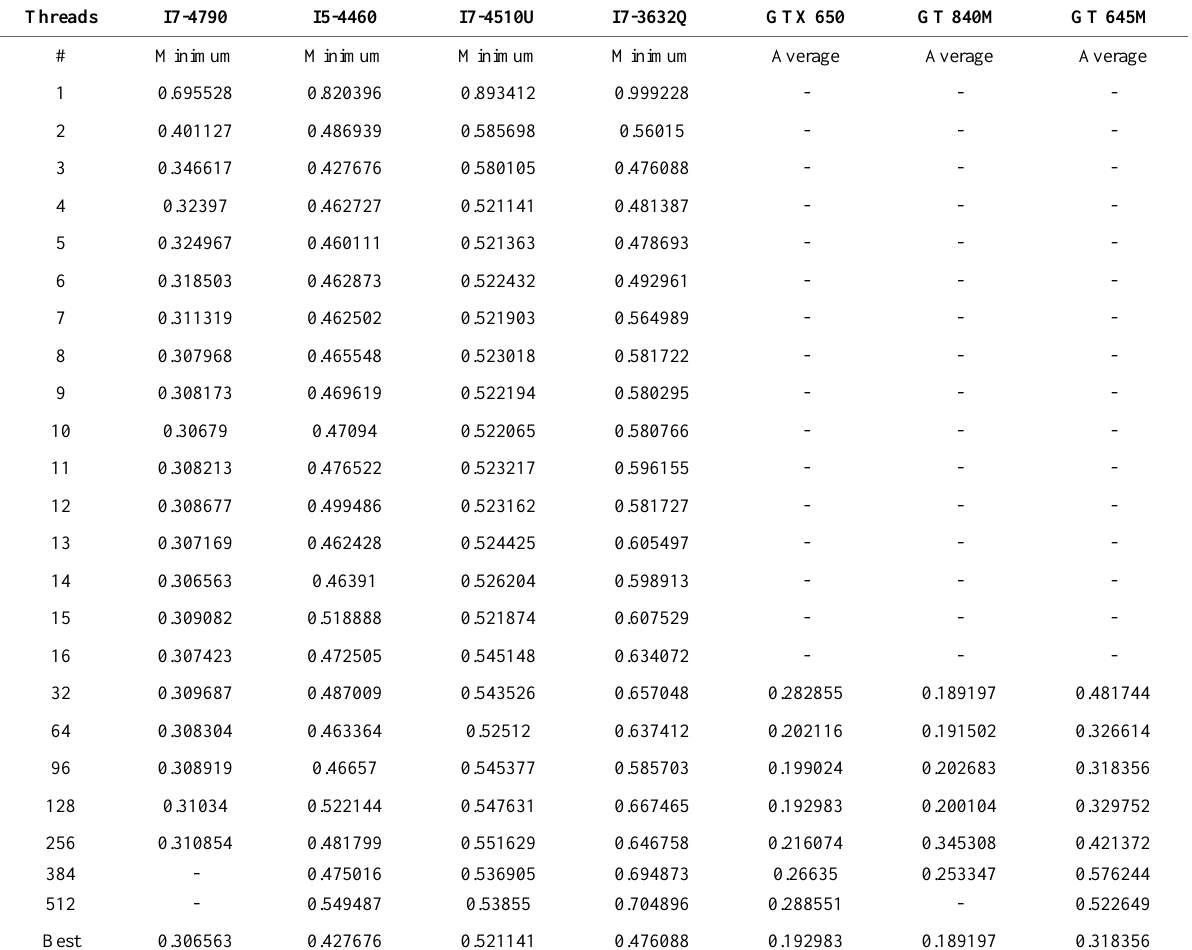
Table 3. Time consumed for image generation in 1080p (in seconds) for CPU and GPU